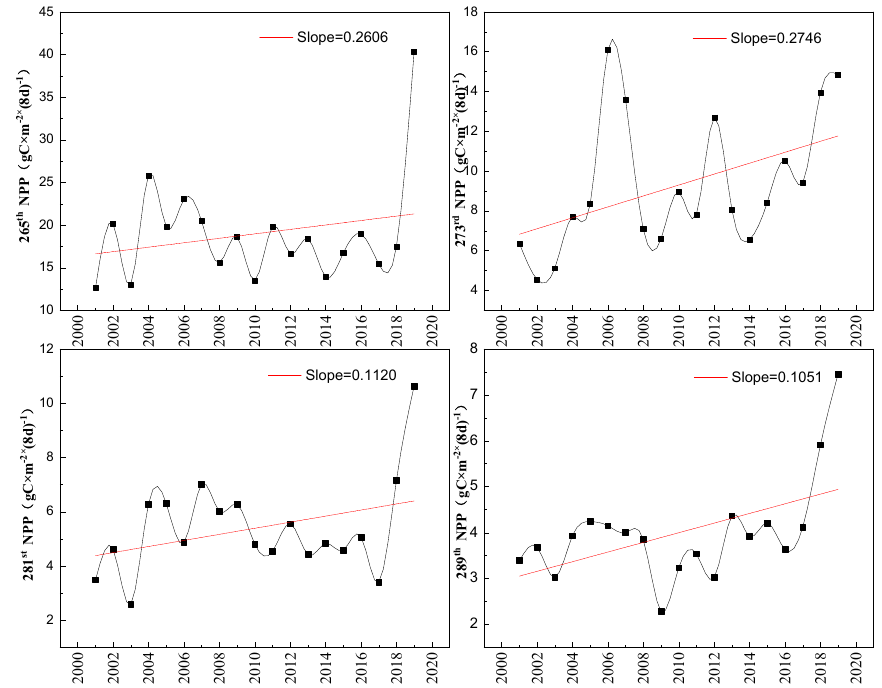
Figure 13. The inter-annual variation characteristics of NPP on daily accumulations, with an eight-day cycle at the end of the vegetation growth season (EOS), from 2001 to 2019